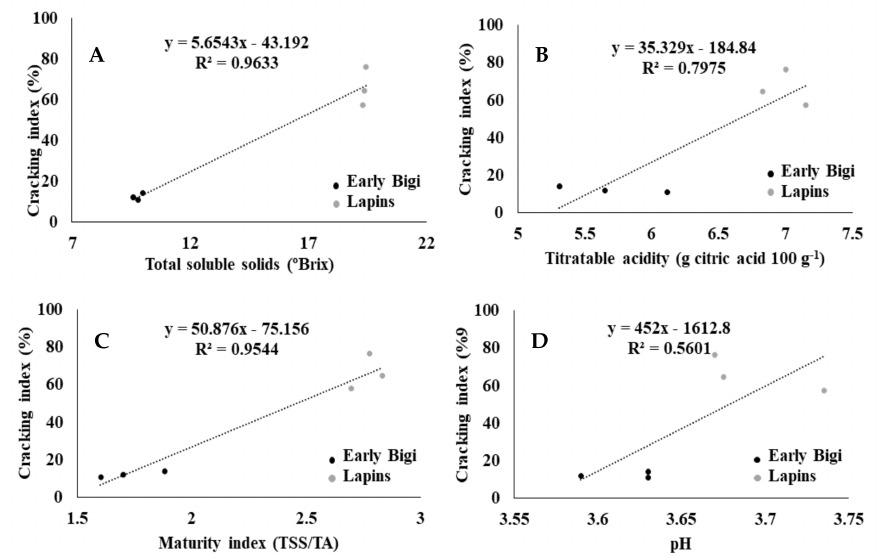
Figure 5. Correlations between ( A ) the cracking index (%) and the total soluble solids ( ◦ Brix), ( B ) the cracking index (%) and the titratable acidity (g citric acid 100 g − 1 ), ( C ) the cracking index (%) and the maturity index (TSS / TA), and ( D ) the cracking index (%) and the pH of two sweet cherry cultivars: Early Bigi and